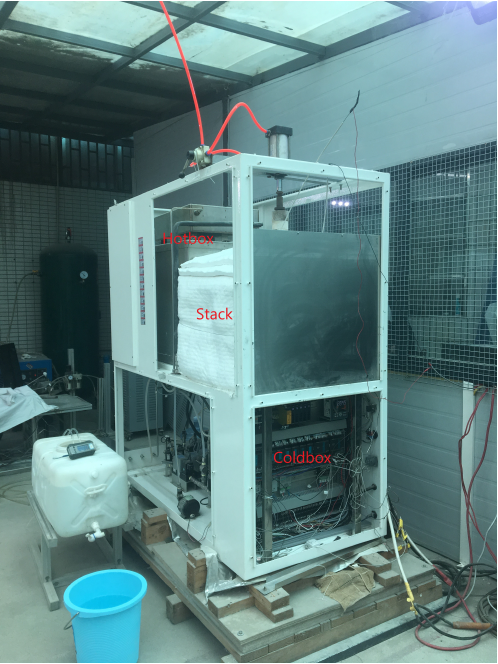
Figure 1. Physical diagram of 1kW SOFC power generation system.